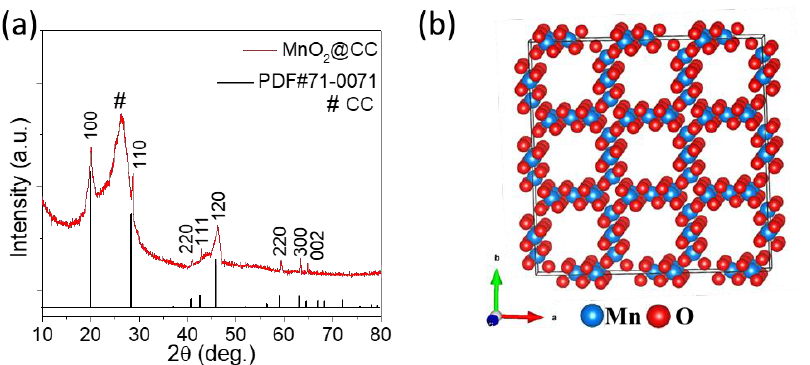
Figure 3. ( a ) XRD spectrum of MnO 2 -NPs@CC. ( b ) Hexagonal crystal structure of MnO 2 with 2 × 2 tunnels.